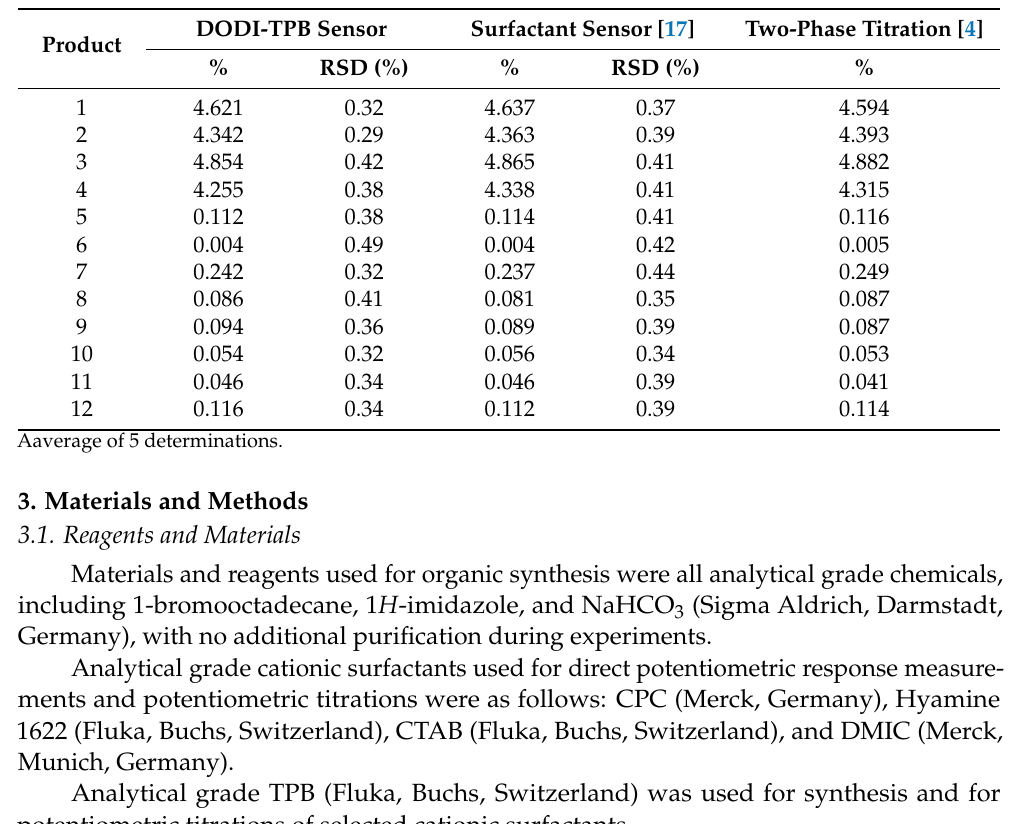
Table 5. Cationic surfactant content in commercial samples obtained by potentiometric titrations with DDS (4 × 10 − 3 M), with the DODI-TPB sensor as an end-point indicator, in addition to a comparison with existing referent